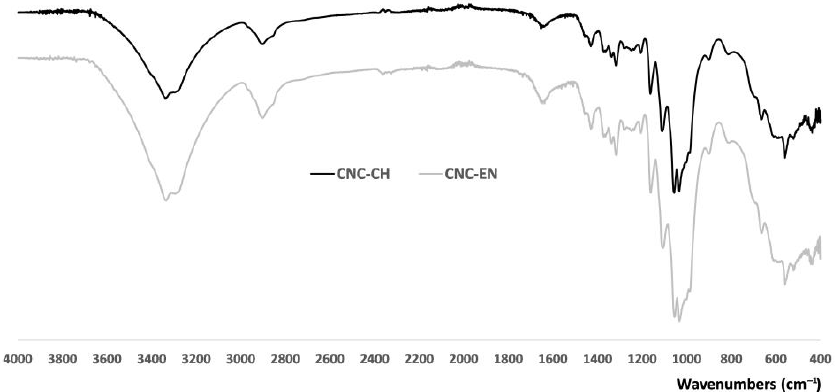
Figure 4. ATR-IR spectra of CNC-CH and CNC-EN. Unprocessed powder samples were analyzed